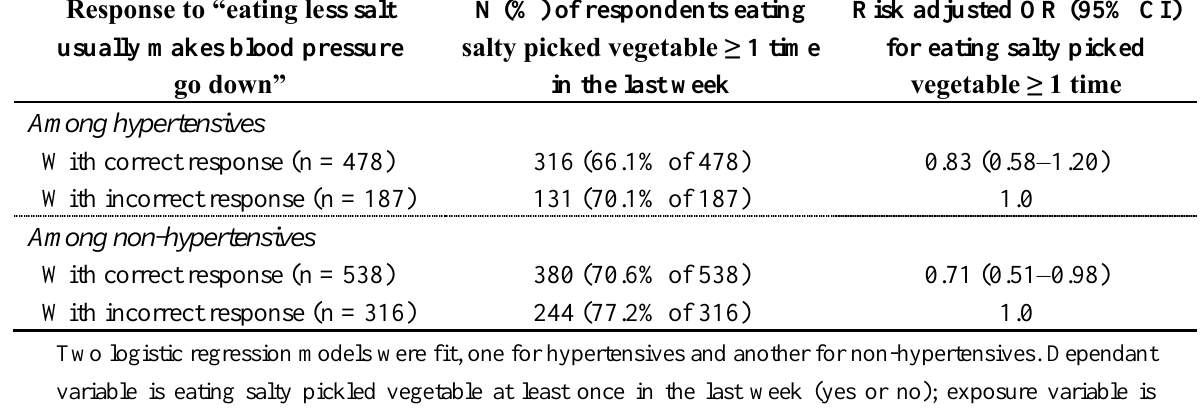
Table 5. Percentage and risk adjusted odds ratio (OR) * with its 95% confidence interval (95% CI) for eating salty pickled vegetable at least once in the last week by correct and incorrect response to the question “eating less salt usually makes blood pressure go down”.